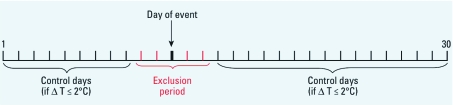
Bidirectional time-stratified case-crossover design. The timeline
represents 1 calendar month (days 1–30). Only control days that were temperature
matched within 2°C with the day of event were selected. ΔT, difference in
temperature between day of event and control day.